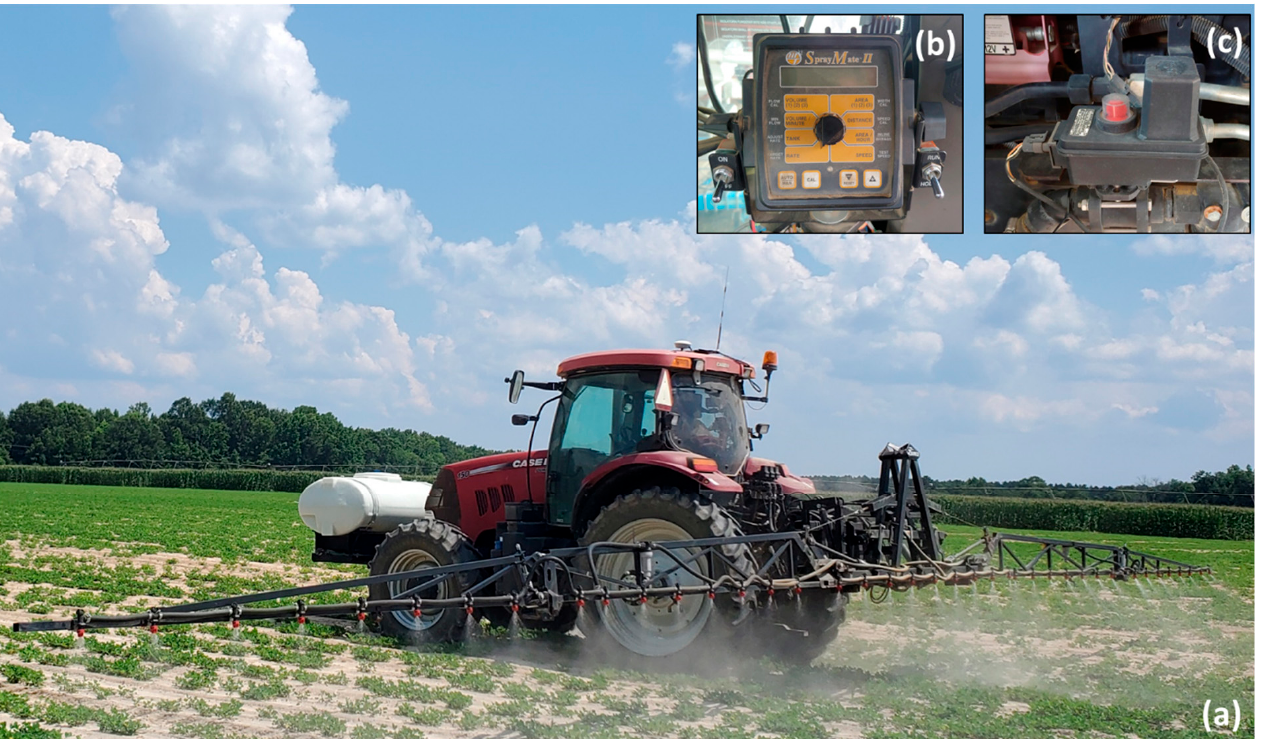
Figure 1. ( a ) The commercial Demco X-fold boom sprayer used for spray performance testing in 2021 and 2022. ( b ) The Micro-Trak MT-2405F II rate controller and ( c ) the TeeJet ® 346BPR-2F-03 regulating valve used in